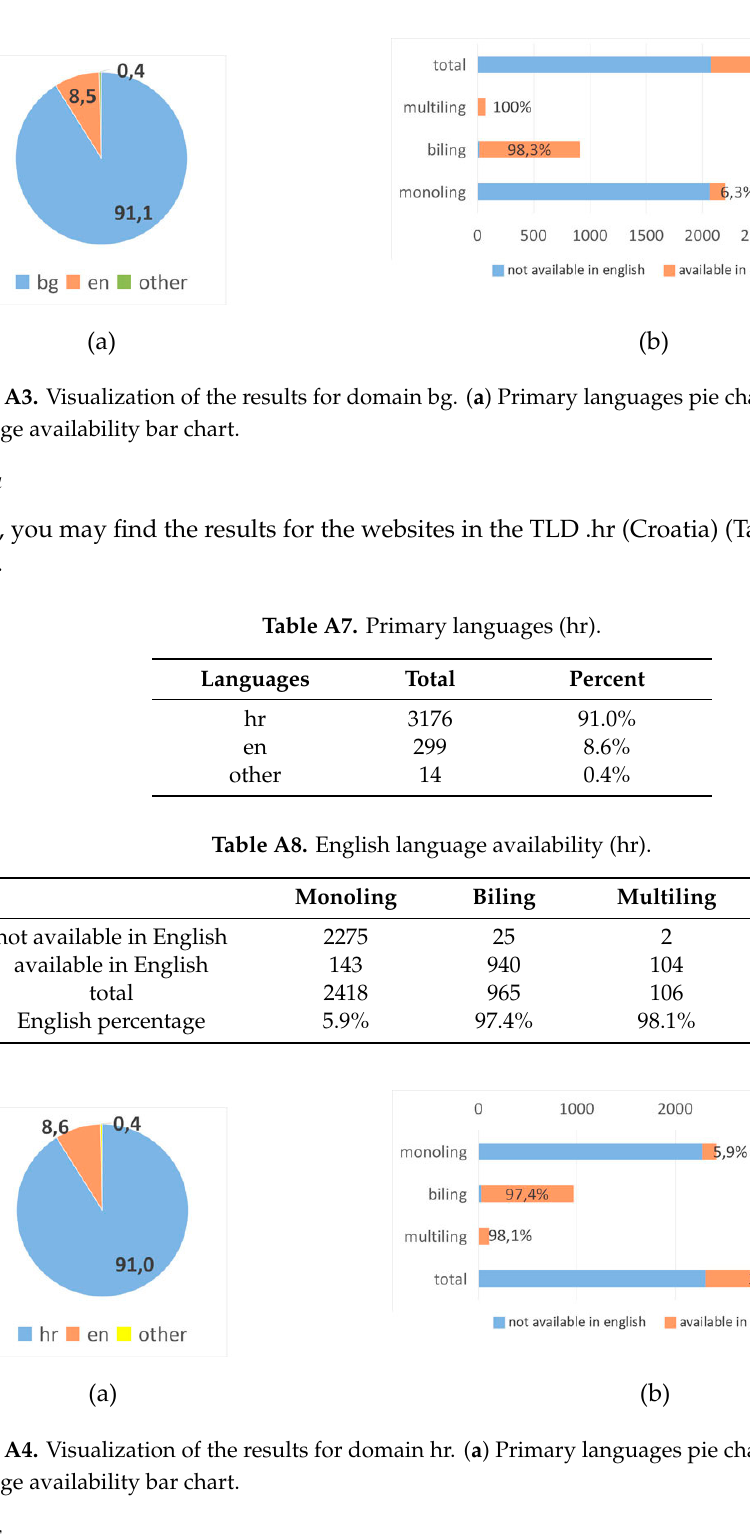
Table A9. Primary languages (cy).